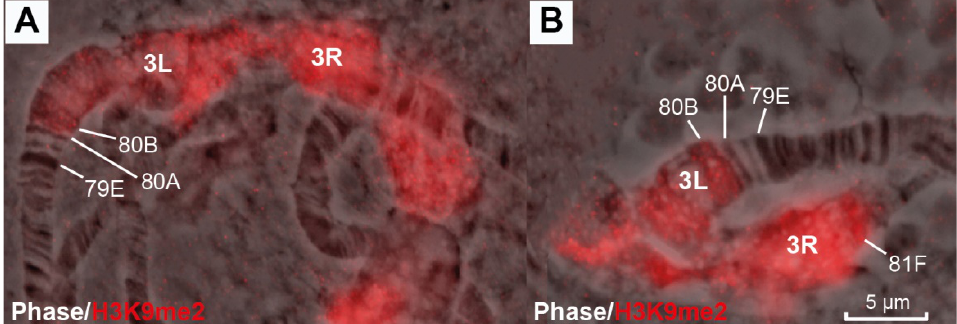
Figure 13. Immunolocalization of histone modification H3K9me2 in the polytene chromosomes of D. melanogaster ( A , B ). Genotypes in both figure parts are Rif1 1 . Scale bar value is the same for both figures.